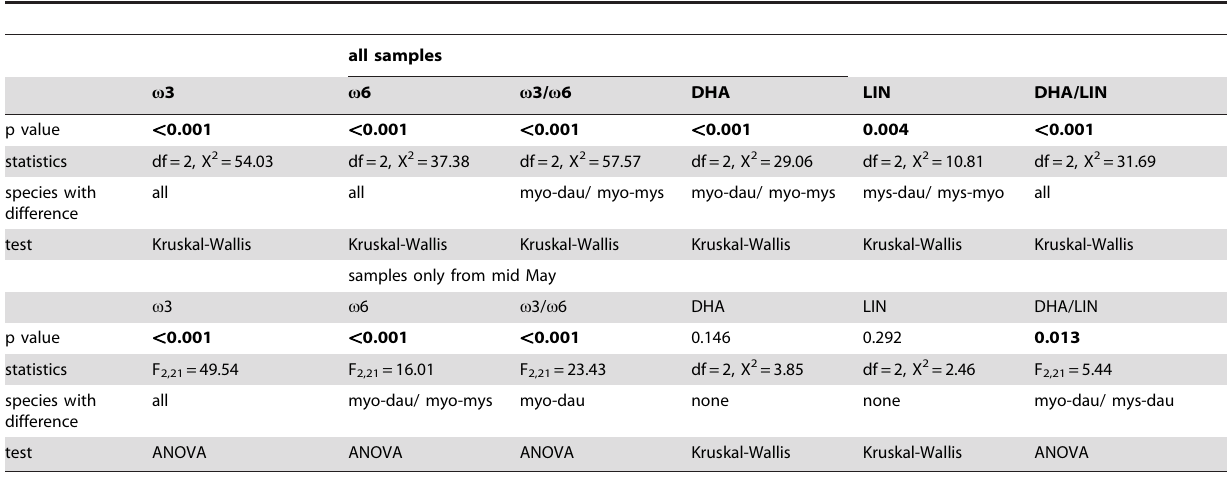
Table 4. Results of the ANOVAs and post-hoc tests and Kruskal-Wallis tests for the comparison of the fatty acid values between the species, using i) all the samples and ii) the samples collected in the middle of May only.